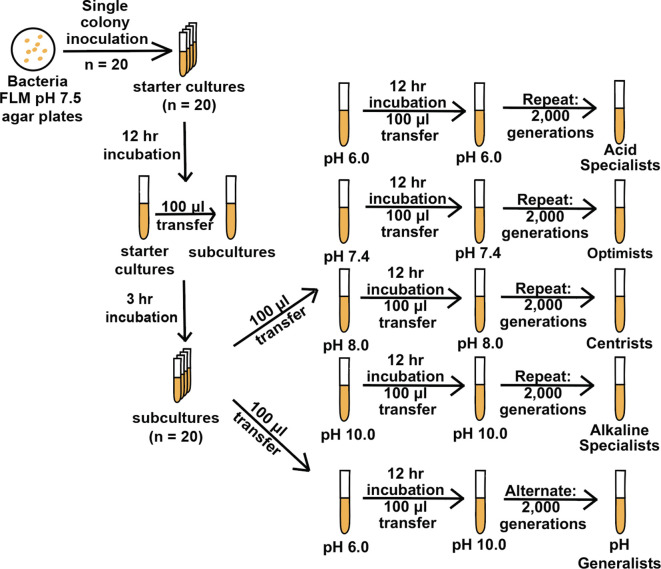
This schematic shows the different selection regimes that generated the acid specialists, optimists, centrists, alkaline specialists, and pH generalists for 
V. fischeri
 after 2000 generations of evolution.